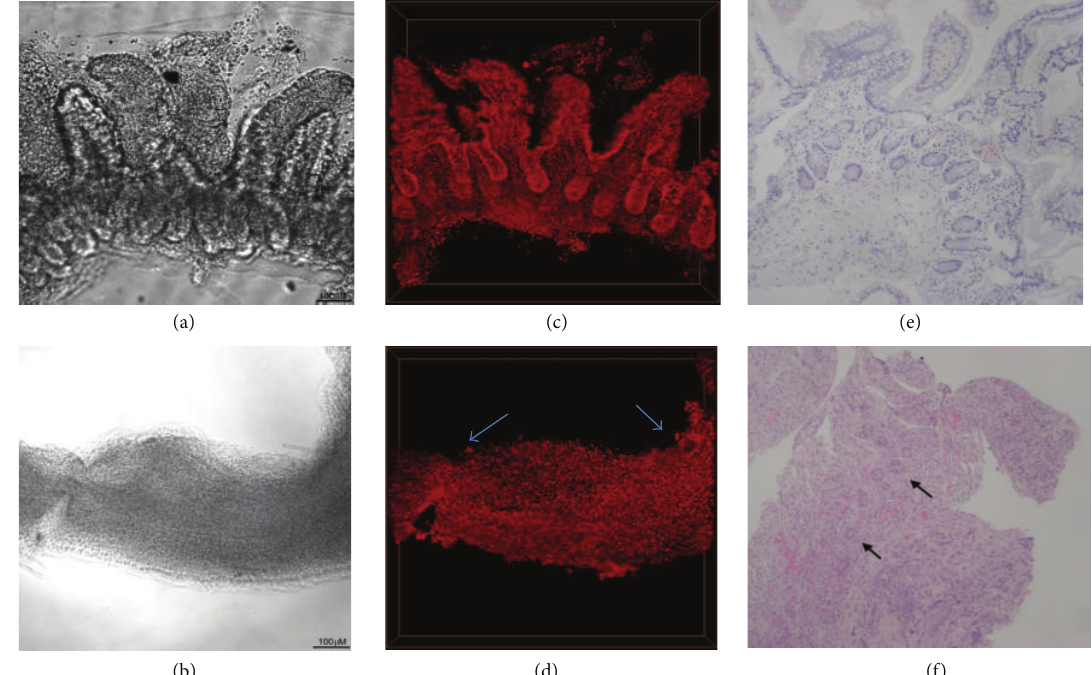
Figure 3: Propidium iodide staining and 3D confocal imaging of the biopsied intestinal tissues with acute rejection. ((a) and (b)) Optically cleared intestinal tissues without (a) or with (b) acute rejection. ((c) and (d)) Propidium iodide fluorescence signals of the intestinal tissues without (c) or with (d) acute rejection. ((e) and (f)) Histopathology of the intestinal tissues without (e) or with (f) acute rejection (H and E stain, 100x). Bar: 100 𝜇 m. Arrow indicated residual crypts in the intestinal tissues with acute